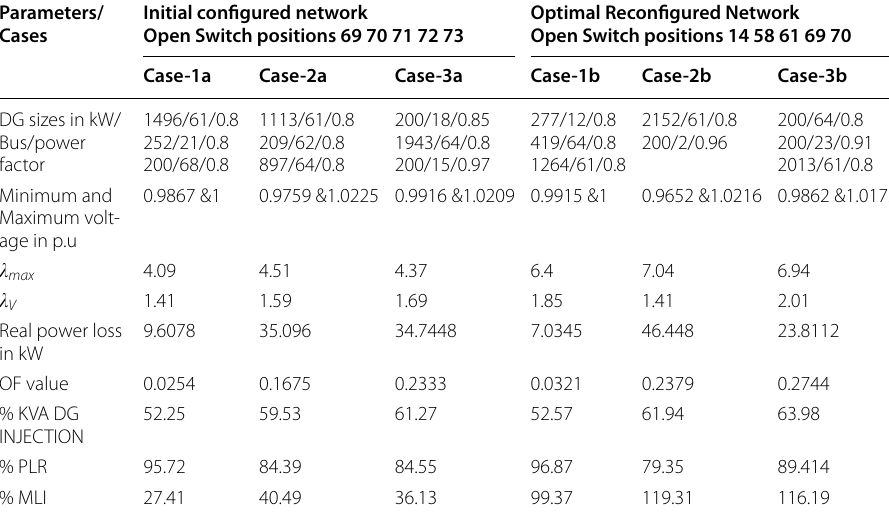
Table 7 Simulation results of 69 bus system for scenario-2 Parameters/